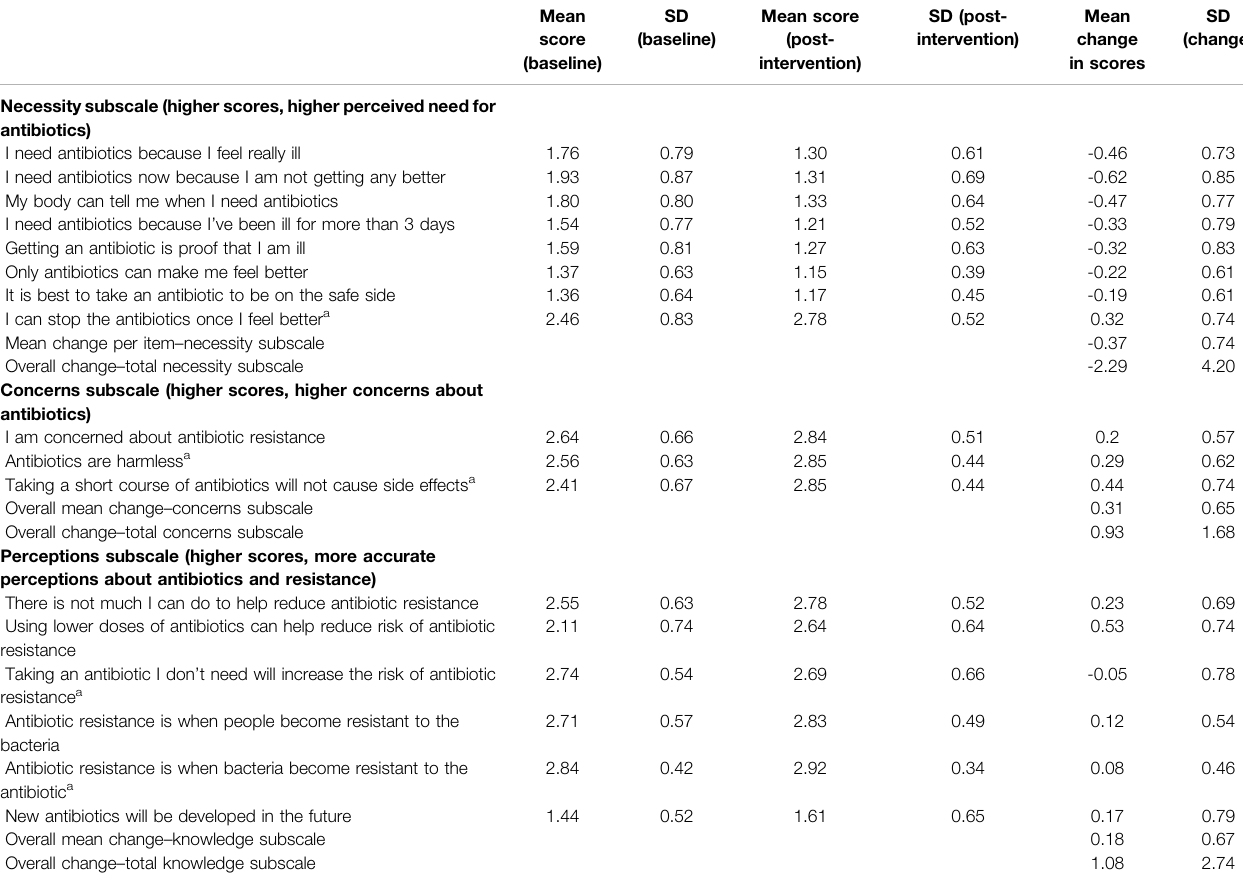
TABLE 2 | Mean (SD) change in Necessity, Concerns and Knowledge scores post-intervention (scores out of a maximum of 3, 1 (cid:1) agree, 2 (cid:1) uncertain, 3 (cid:1)